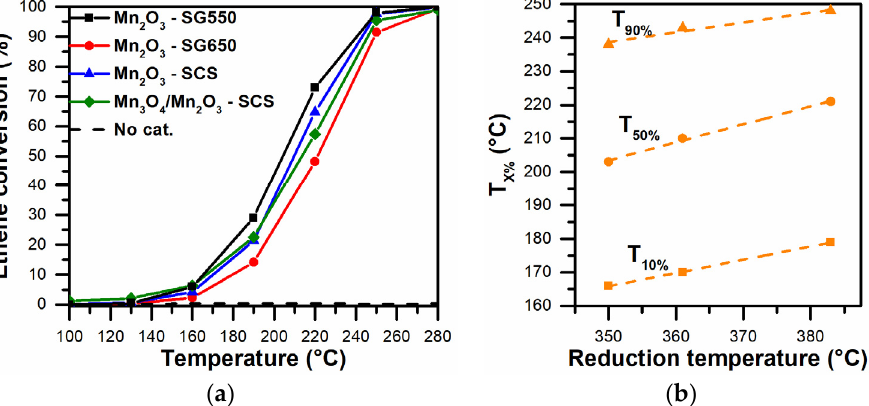
Figure 7. ( a ) Catalytic performances in the oxidation of C 2 H 4 and ( b ) correlation between the low- temperature reduction peak and the catalytic performance in C 2 H 4 oxidation (over Mn 2 O 3 catalysts) in terms of T 10% , T 50% and T 90% .